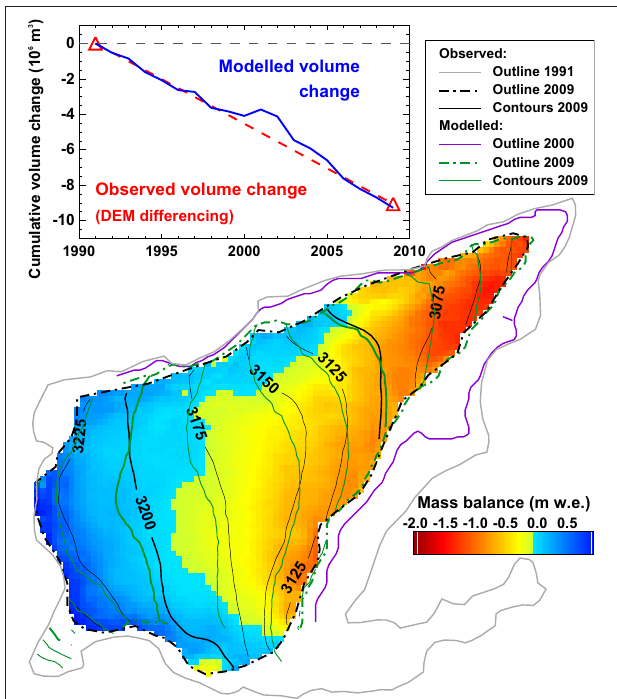
FIGURE 4 | Calculated change in extent for Vadret dal Murtèl (Figure 3) during the calibration period 1991–2009. Modeled outlines are displayed for the year 2000 and 2009 (purple, green). Observed outlines for 1991 (model initialization) and 2009 are shown. Contour lines refer to observed (black) and calculated (green) ice surface topography in 2009. Mass balance distribution is given for a typical year within the calibration period (1998/99). The inset shows observed volume change from DEM differencing and cumulative annual volume change based on the model calibrated to these data.